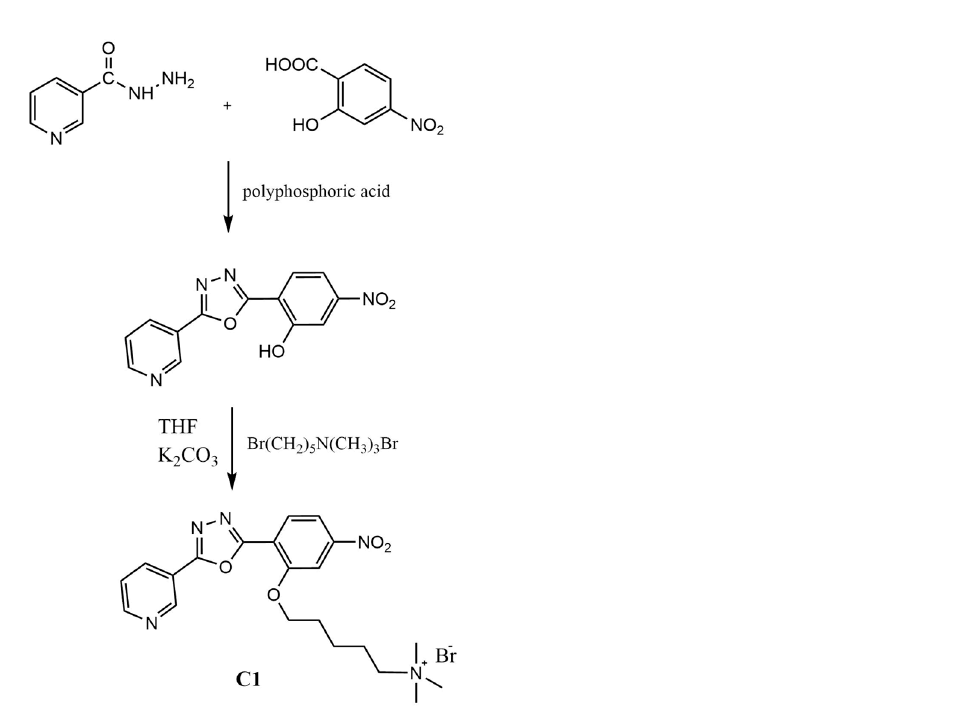
Scheme 1. Schematic representation of the two-step synthetic route to the target compound